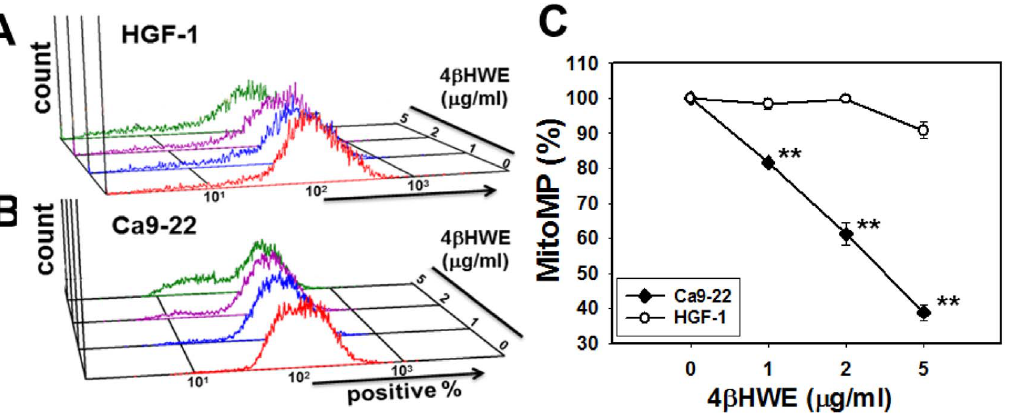
Figure 3. Reduction of mitochondrial membrane potential (MitoMP) differed between oral cancer Ca9-22 cells and normal oral HGF-1 cells after 4 b HWE treatment. (A, B) Representative flow cytometry-based MitoMP profiles for 4 b HWE-treated Ca9-22 and HGF-1 cells. Cells were treated with varying concentrations (0–5 m g/ml) of 4 b HWE for 24 h. (C) Quantification analysis of MitoMP intensity. Data are presented as means 6 SDs% (n=3). The asterisks indicate statistically significant differences between the Ca9-22 and HGF-1 cell lines after treatment with similar concentrations of 4 b HWE ( t -test, P , 0.0005**).